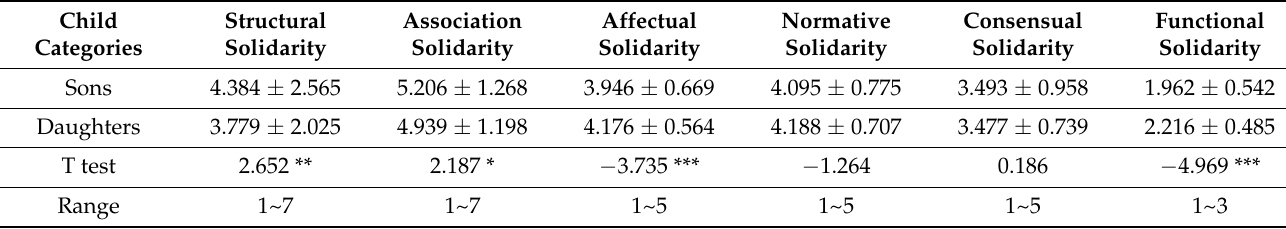
Table 3. Gender test of family intergenerational